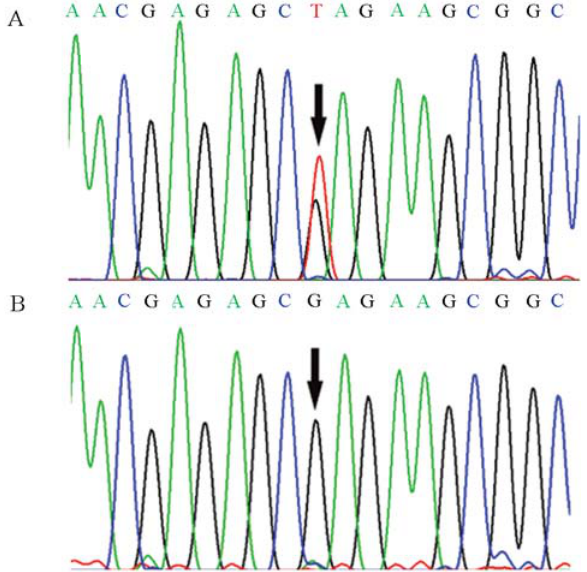
Figure 3 - Mutation analysis. The sense sequence electropherogram of the SOX9 exon 2 from (A) the patient and (B) control. The proband shows a heterozygousG>Tmutationconvertingaglutamicacidresidue(GAG)to a stop codon (TAG), designated as